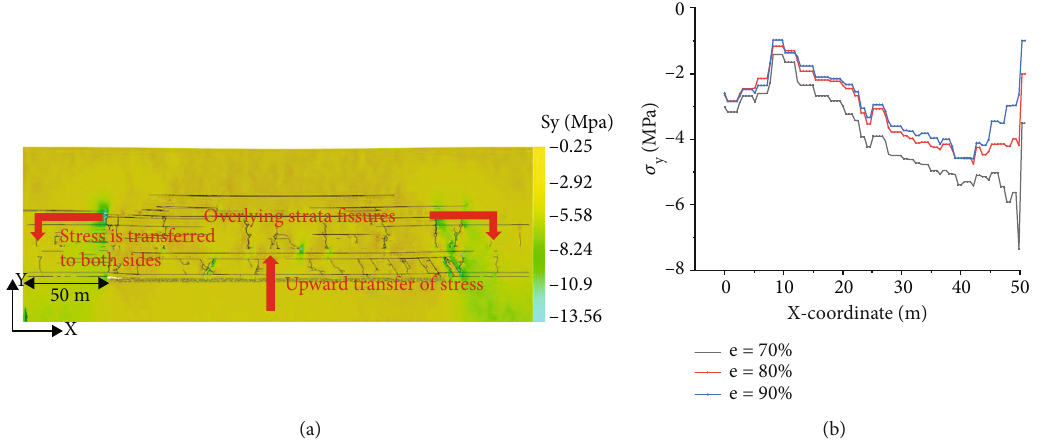
fl uidization mining: (a) the contour plot of σ y of in situ